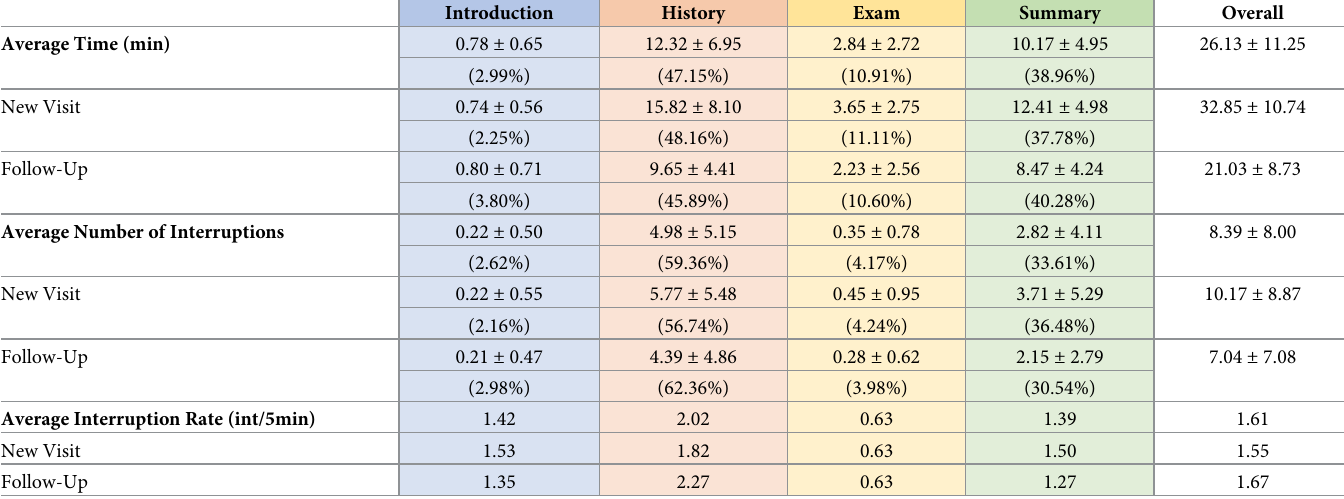
Table 1. Time distribution and interruption rate